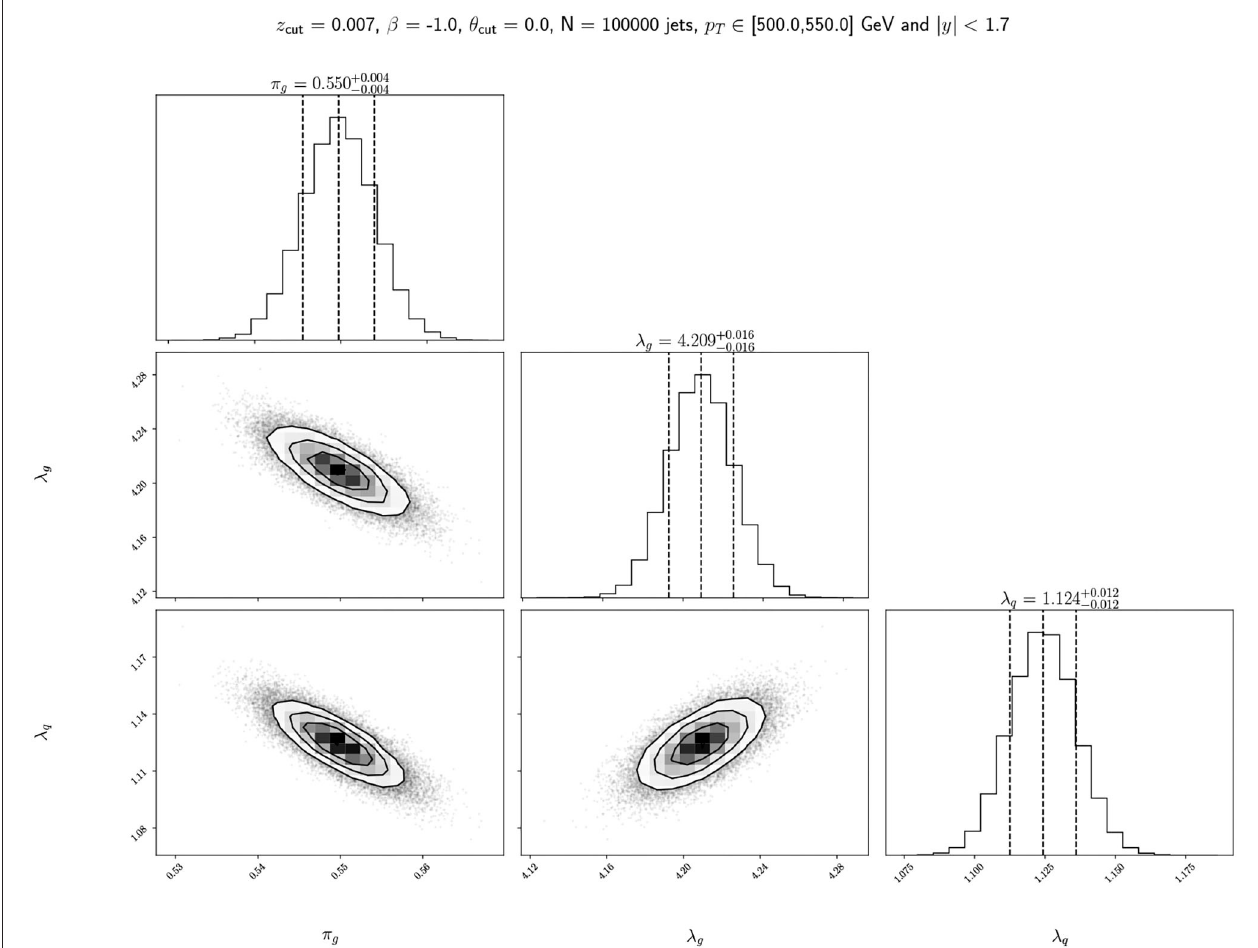
FIGURE 7 | Corner plots for the model parameters π g , λ q , and λ g . The diagonal plots are the 1D marginalized posterior distributions for each parameter while the off-diagonal plots are the pairwise 2D distributions marginalized over the third parameter. The π q distribution can be obtained by considering 1